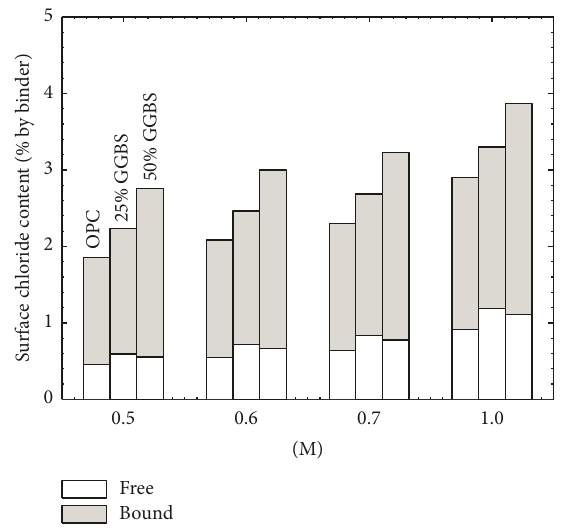
Figure 2: Surface chloride contents with variation of external chloride